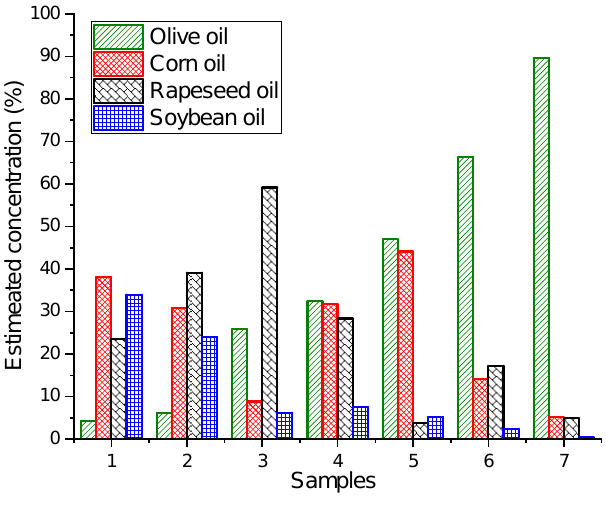
Figure 5. Bar plot of estimated concentrations of extra virgin olive oil (EVOO), corn, rapeseed and soybean oil resulting from non-negative least squares of quaternary mixtures shown for seven samples as an